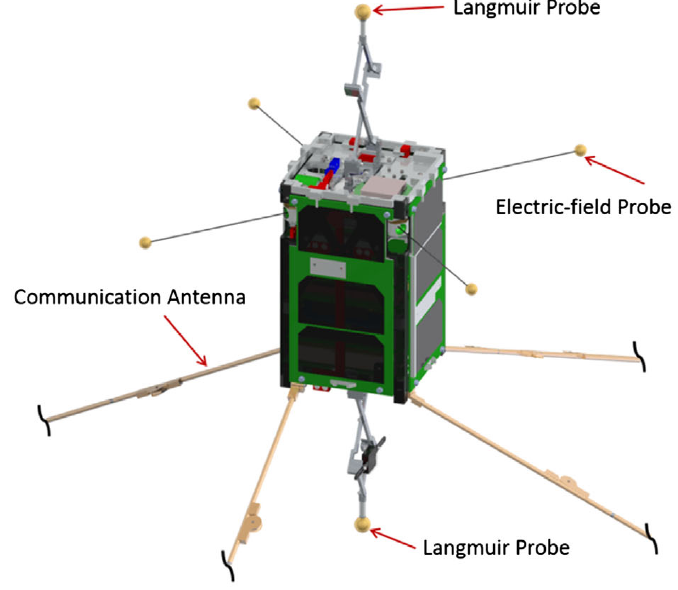
Figure 6. Diagram of the DICE CubeSat with deployables. Figure from Fish et al.